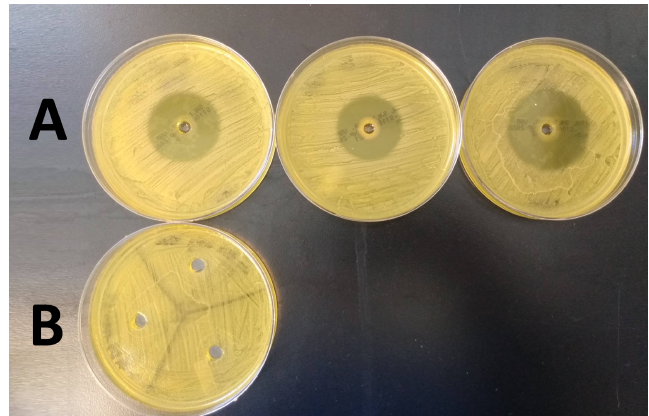
Figure 6. Results of the ZOI tests performed in triplicate for 2% oregano oil gel (Row ( A )), and HA only gel (Row ( B